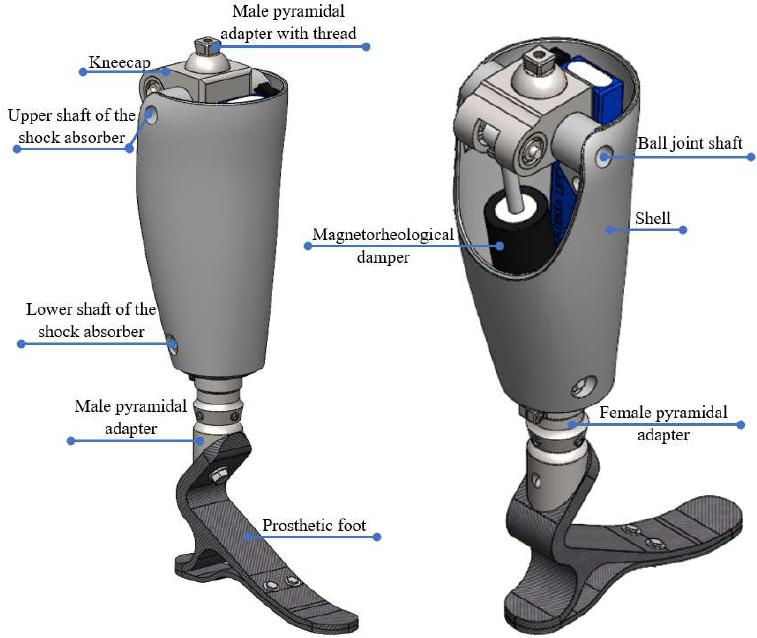
Figure 2. Front and posterior view of the transfemoral prosthesis.